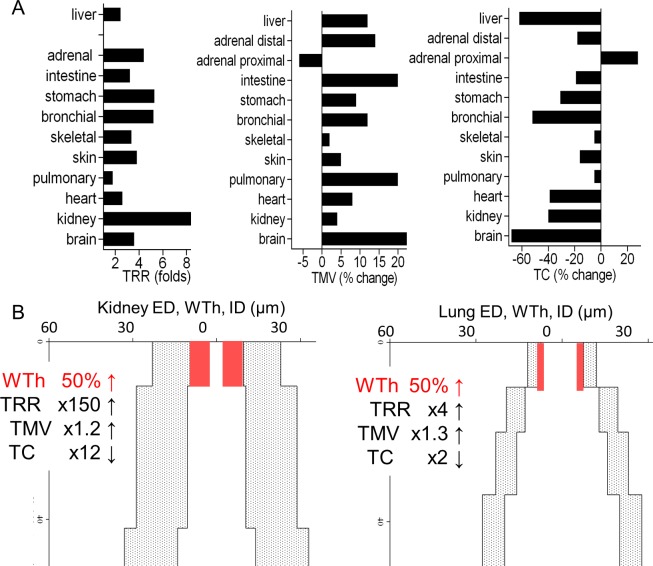
Hemodynamic parameters are enhanced variously in different organs.(A) There was no clear correlation between the values of terminal relative resistance (TRR), terminal capacity (TC), and terminal media volume (TMV). For example, in the brain enhanced TMV corresponded to a large drop in TC but a small increase in TRR. In the kidney a small elevation in TMV corresponded to a small lowering in TC but augmented TRR. (B) An equal 50% increase in wall expansion in kidney and lung arteries would cause marked differences in TRR and TC increases, while TMV would only increase mildly and remain comparable between the two organs. Different dynamics for TRR, TMV, and TC are the result of different initial organ specific dimensions. ED–external diameter; ID–internal diameter; WTh–wall thickness; x—fold increase.